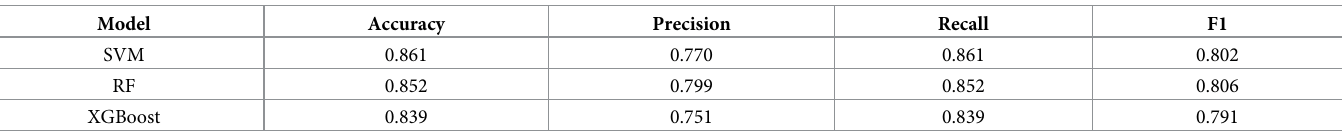
Table 5. Classification performance of each machine learning